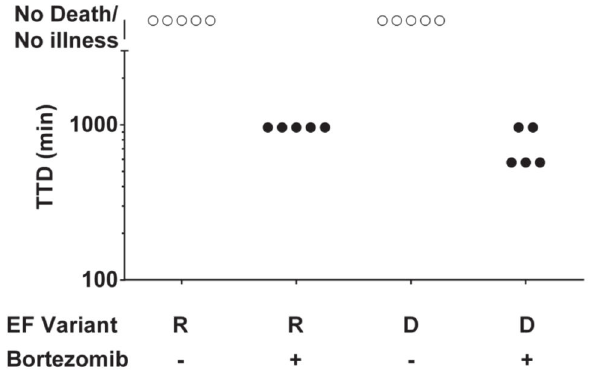
Figure 5. Proteasome inhibition enhances toxicity of destabilized EF variants in vivo. C57BL/6J mice were injected intravenously with 20 µg bortezomib 30 min prior to challenge with 75 µg of EF N-terminal variants+75 µg PA. Animals were monitored every 4-6 h for signs of malaise and/or death. Open circles denote living mice, and black circles denote mouse